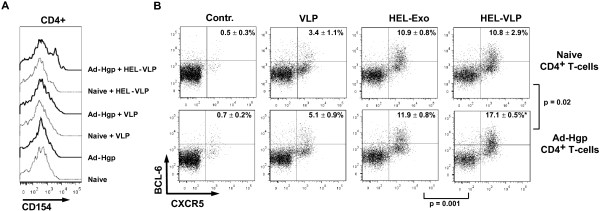
Activation and differentiation of CD4+ T cells by HEL-specific B-cells exposed to HEL-VLPs. CD4+ T-cells from non-immunized (naive) or GagPol immunized (Ad-Hgp) mice were co-cultured with naïve B-cells from SW-HEL mice and splenic DCs in the presence of HEL-VLPs or control VLPs lacking HEL. (A) After one day, cells were stained for CD4 and the CD-154 activation marker. The experiment was performed three times with similar results, data of one representative experiment are shown. (B) After 6 days of incubation, cells were stained for CD4, intracellular BCL-6, and CXCR-5. Follicular-helper cells were defined by co-expression of BCL-6 and CXCR-5. Numbers in upper right corners indicate mean percentage ± standard deviation of follicular-helper cells among total CD4+ T cells from three independent experiments. Each of the three experiments was performed in duplicates and the mean of the duplicates was used for statistical analysis of the mean of the three experiments. P values of unpaired t-tests for the indicated group comparisons are shown.